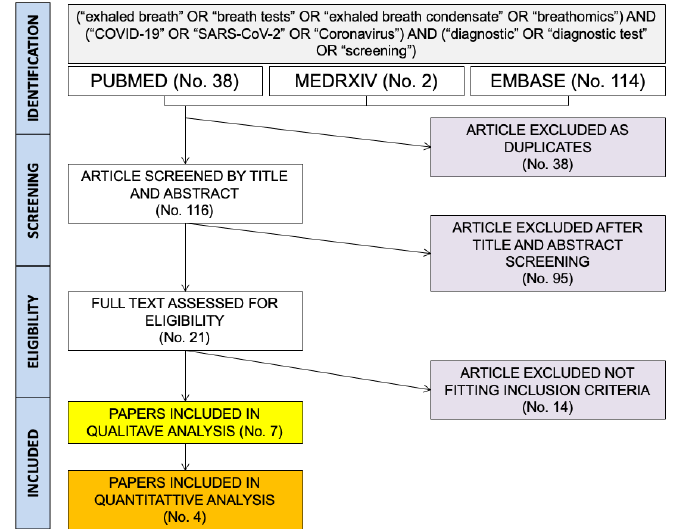
Figure 1. The process of studies retrieval and inclusion adopted in the present systematic review and meta-analysis. A total of 7 studies were included in qualitative analysis, and 4 of them were summarized in quantitative analysis.